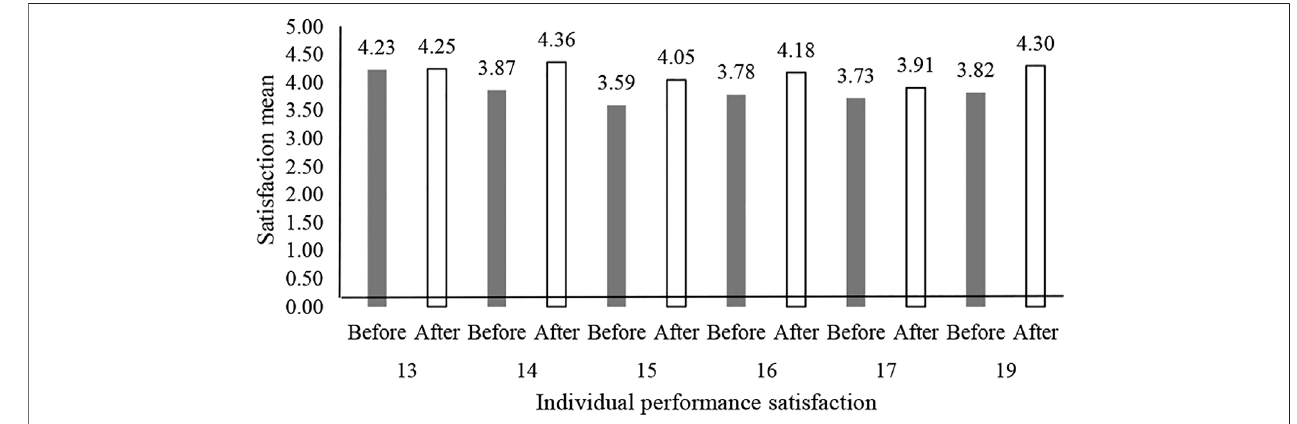
FIGURE 2 | Satisfaction of individual performance chart by age.